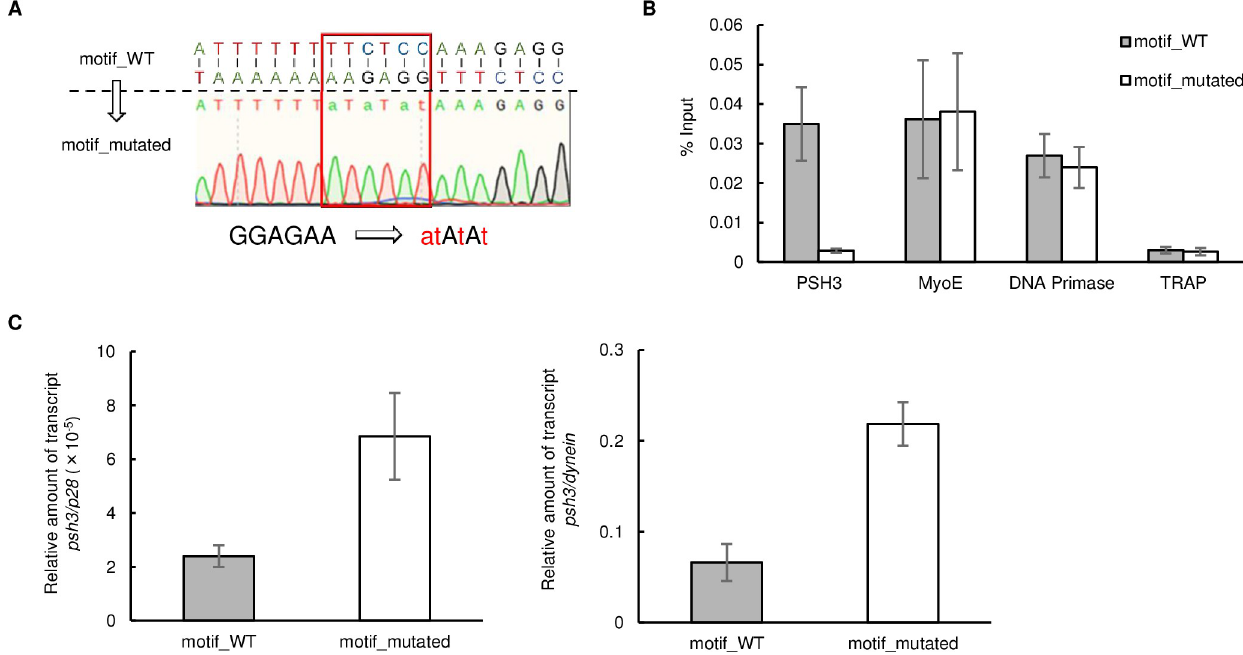
Fig 5. Disruption of the binding motif of Pb AP2-FG2 in the upstream region of psh3 . (A) Genomic sequence around the binding motif of Pb AP2-FG2 located upstream of psh3 , and Sanger sequence result of the region in motif_mutated parasites. (B) ChIP-qPCR analysis of Pb AP2-FG2 at the mutated site upstream of psh3 . Grey and white bars indicate %input for motif_WT and motif_mutated, respectively. Error bars indicate the standard error of the mean % input values from three independent experiments. [PSH3: Parasite-Specific Helicase 3, MyoE: Myosin E, DNA Primase: DNA Primase large subunit, TRAP: Thrombospondin-Related Anonymous Protein] (C) RT-qPCR analysis of psh3 in motif_WT and motif_mutated parasites. The relative transcript level of psh3 against p28 and dynein is presented at the left and right, respectively. Error bars indicate the standard error of the mean from three independent experiments.